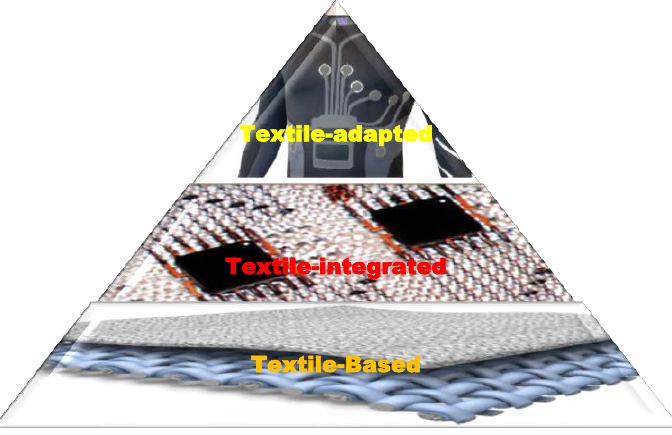
Figure 7. Levels of integration of electronic components.